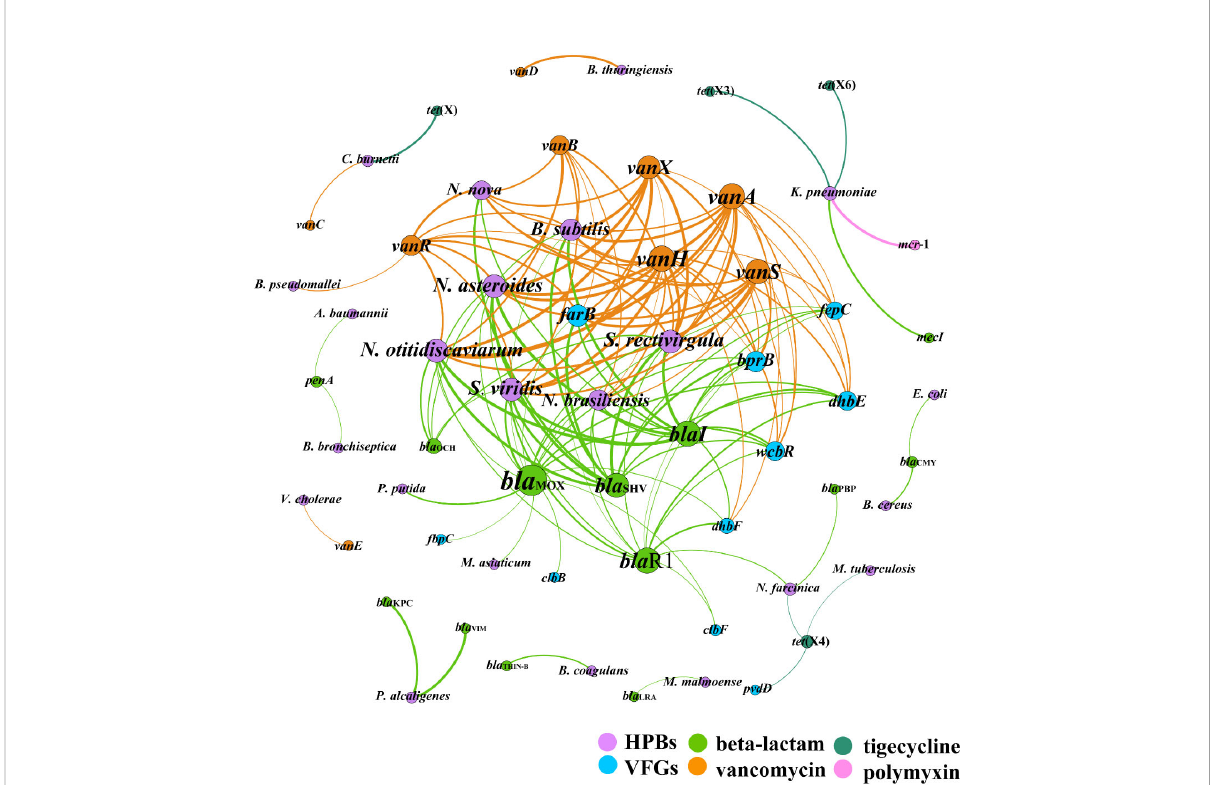
FIGURE 6 Network of co-occurring clinically critical antibiotic resistance genes, human bacterial pathogens, and virulence factor genes. A node represents each element, and a connection ( i . e ., edge) represents a signi fi cant ( P < 0.05) and strong (Pearson ’ s r > 0.70) pairwise